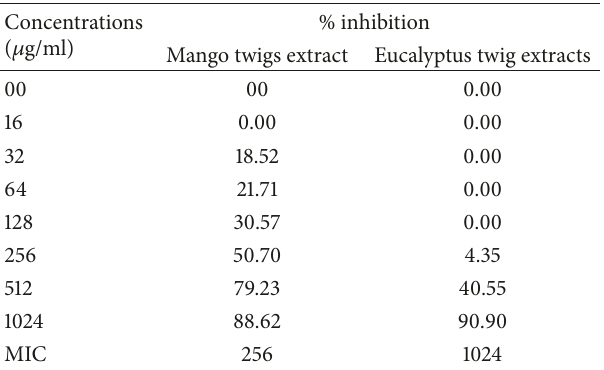
Table 3: Minimum inhibitory concentration of mango and eucalyp- tus twigs extract against Streptococcus mutans .